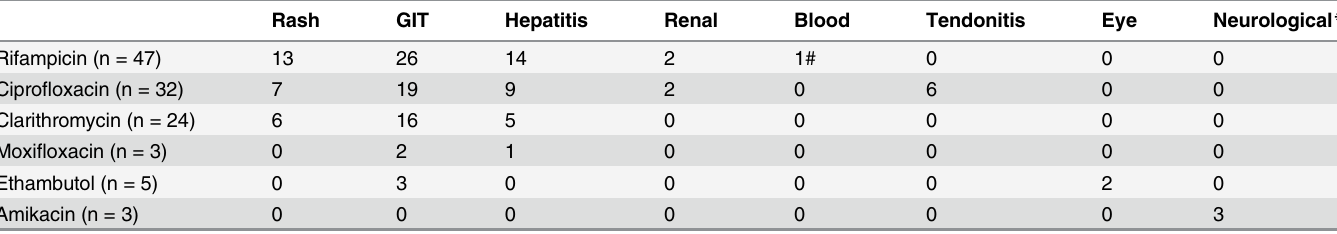
Table 3. Specific complications associated with individual antibiotics for all ages combined. Rash GIT Hepatitis Renal Blood Tendonitis Eye Neurological